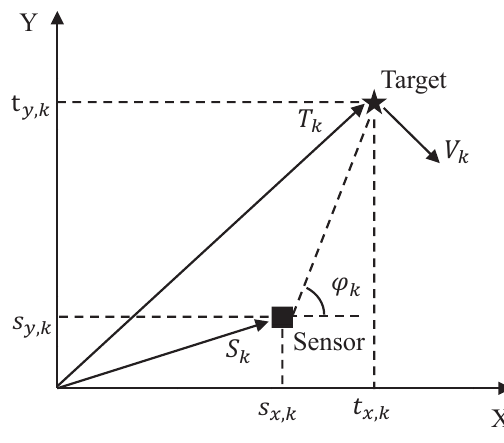
Figure 1. Schematic diagram of 2D bearing-only